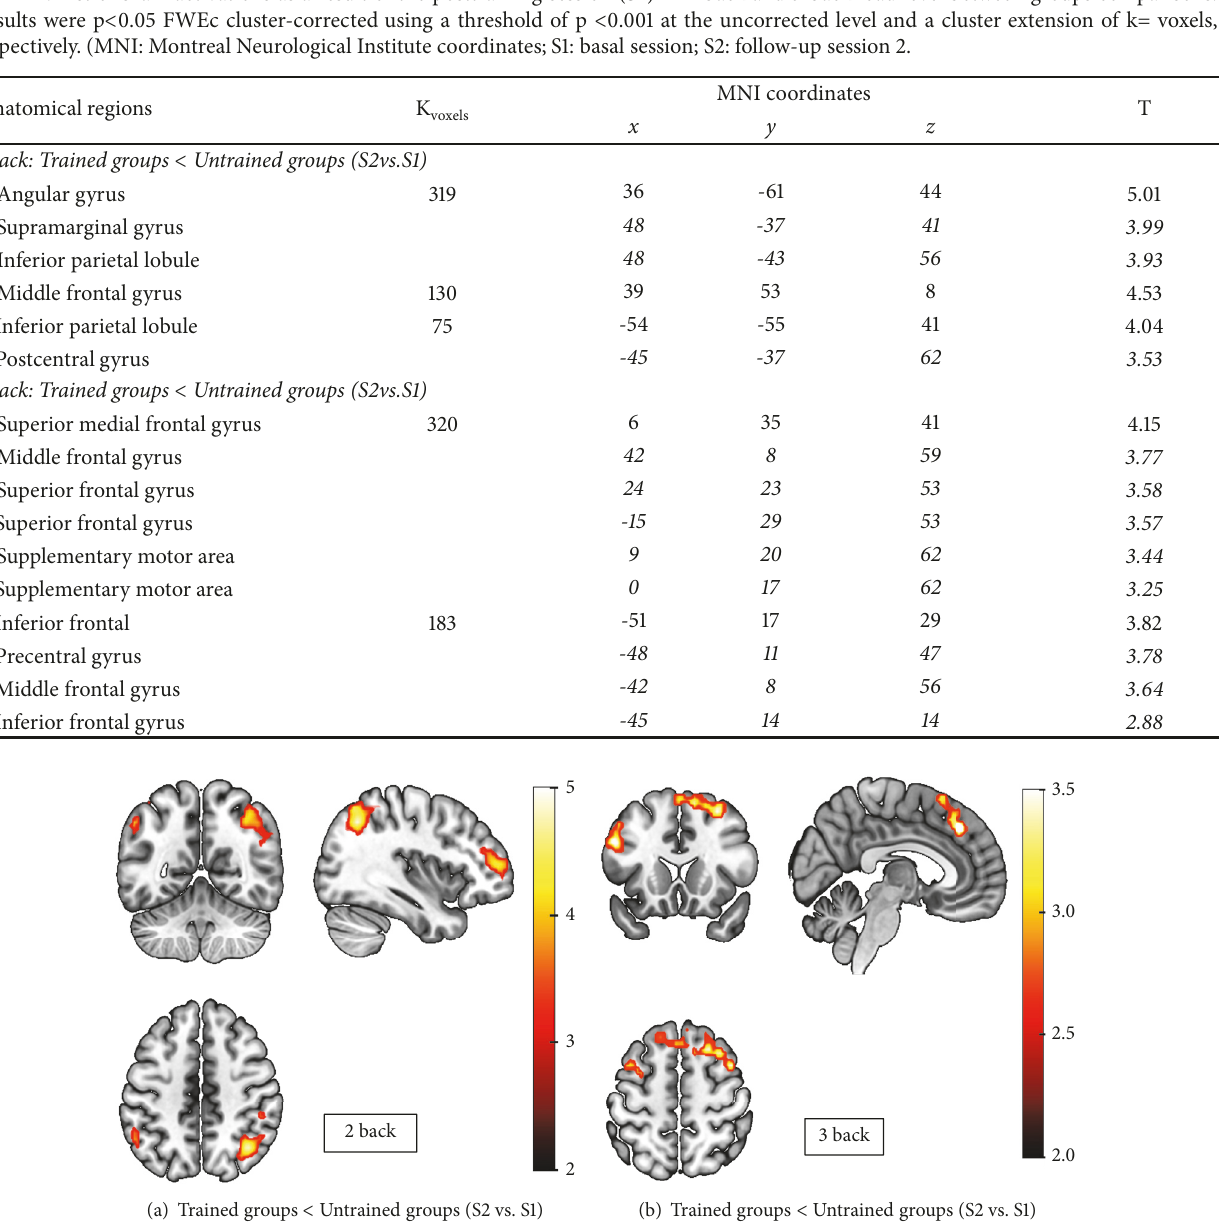
Figure 2: Neuroimaging results. (a) depicts the decreased activation (S2 < S1) in frontoparietal areas observed during 2-back performance in trained groups as compared to untrained groups (FWEc=75, p < 0.001). (b) shows the decreased frontoparietal activations (S2 < S1) of trained groups as compared to untrained groups during 3back performance (FWEc=183, p <